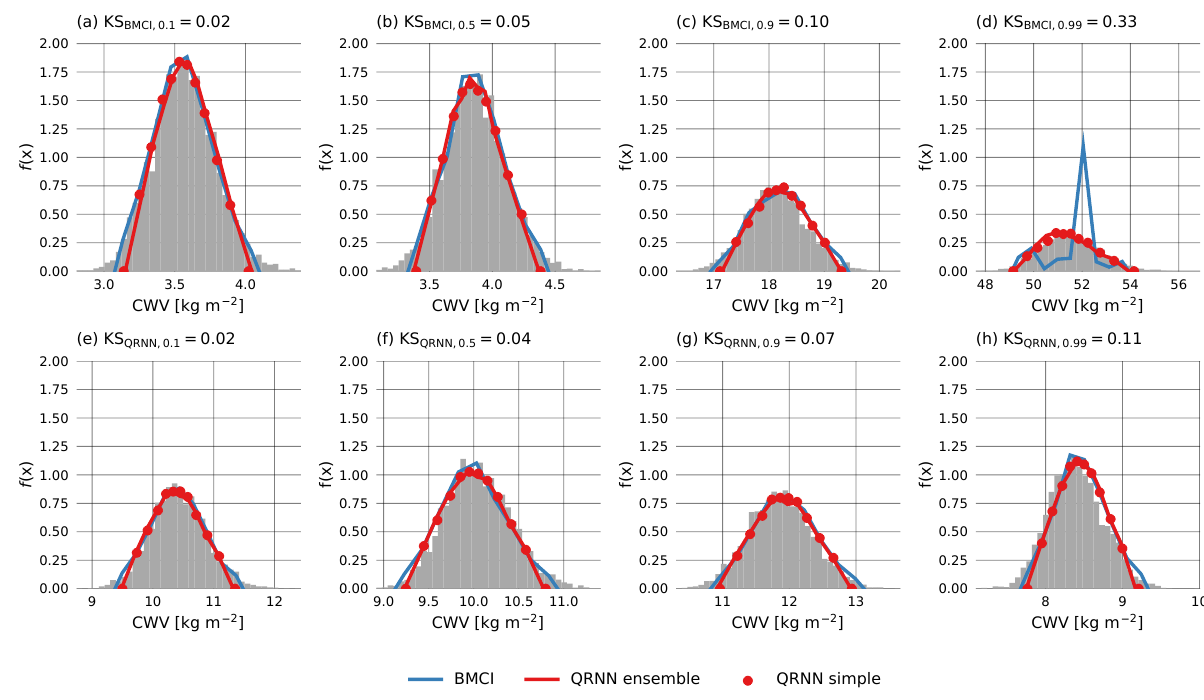
Figure 4. Retrieved a posteriori PDFs corresponding to the CDFs displayed in Fig. 3 obtained using MCMC (gray), BMCI (blue), a single QRNN (red line) and an ensemble of QRNNs (red marker).